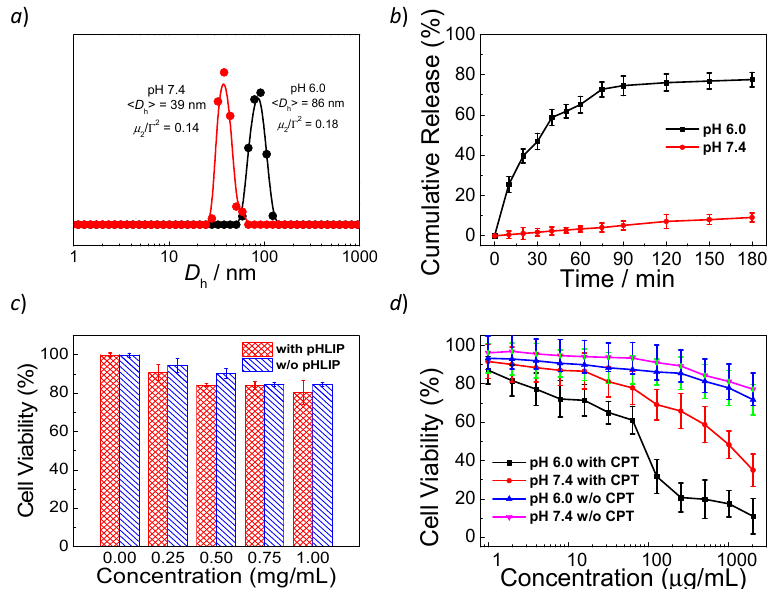
Figure 3. ( a ) Hydrodynamic diameter distributions of camptothecin (CPT)-loaded CCL micelles at pH 7.4 and pH 6.0, respectively; ( b ) CPT release profiles from CCL micelles at pH 7.4 and 6.0; ( c ) In vitro cytotoxicity of CCL micelles with and without pHLIP as determined by MTT (3-(4,5-dimethyl-2- thiazolyl)-2,5-diphenyl-2- H -tetrazolium bromide) assay against A549 cells at pH 7.4; and ( d ) in vitro cytotoxicity of pHLIP-decorated CCL micelles with or without CPT internalized under different pH as determined by MTT assay against A549 cells. For the cytotoxicity tests, A549 cells were firstly incubated with micelles for 2 h and were washed three time with PBS buffer, followed by a further incubation for 24 h.